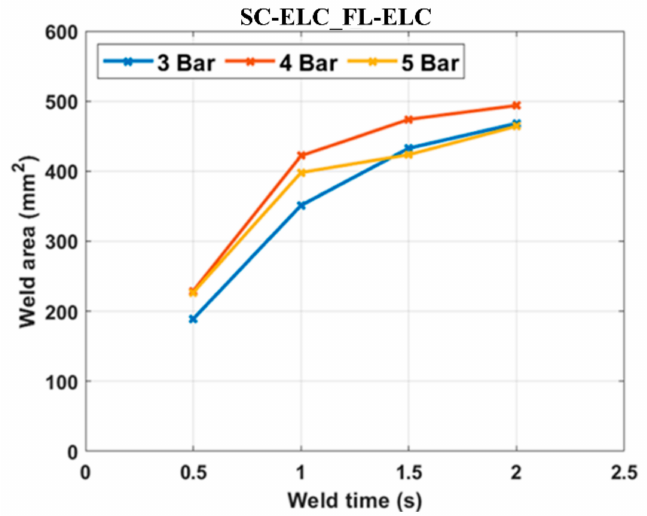
Figure 12. Welded area under all the welding conditions for the SC-ELC_FL-ELC configuration.